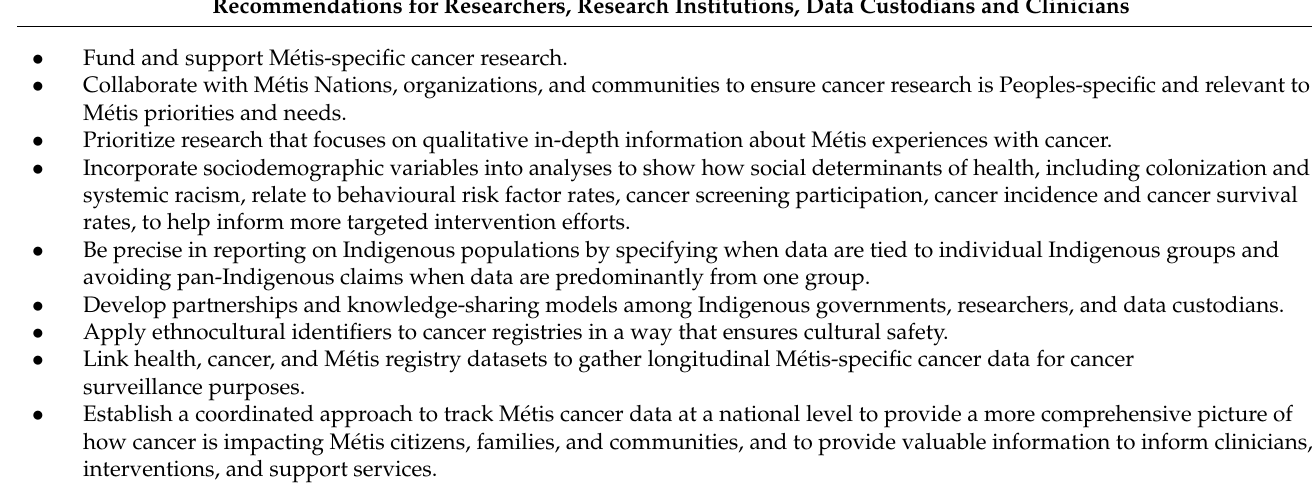
Table 8. Recommendations determined by records and review